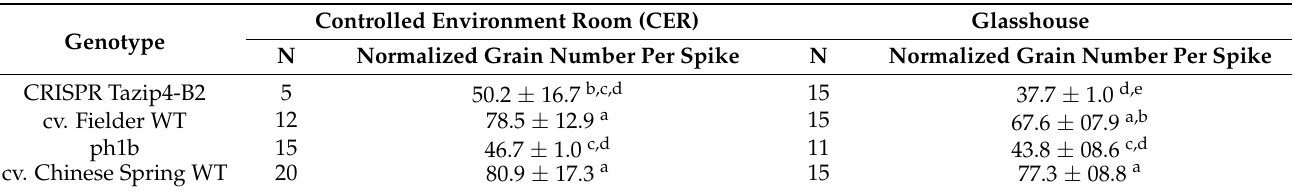
Figure 4. The effect of TaZIP4-B2 on grain setting. ( a ) Grain number per spike in the two Tazip4-B2 mutants and their WT controls under CER and glasshouse growth conditions. Percentages indicate the difference in grain setting between each mutant and its WT. n refers to the number of biological replicates. ( b ) Normalised grain number per spike in the three treatments of the emasculation/pollination experiment. Treatments with the same letter are not significantly different. n refers to the number of emasculated/pollenated spikes. ( c ) Seed germination rates resulting from different pollen donor and pollen recipient genotypes. n refers to the number of seeds included in the seed germination experiment. Table 2. Mean Normalized grain number per spike for the two Tazip4-B2 mutants and their corresponding wild types under CER and glasshouse growth conditions. N is the number of biological replicates per genotype. Mean values with standard deviation are shown. Treatments with the same letter are not significantly